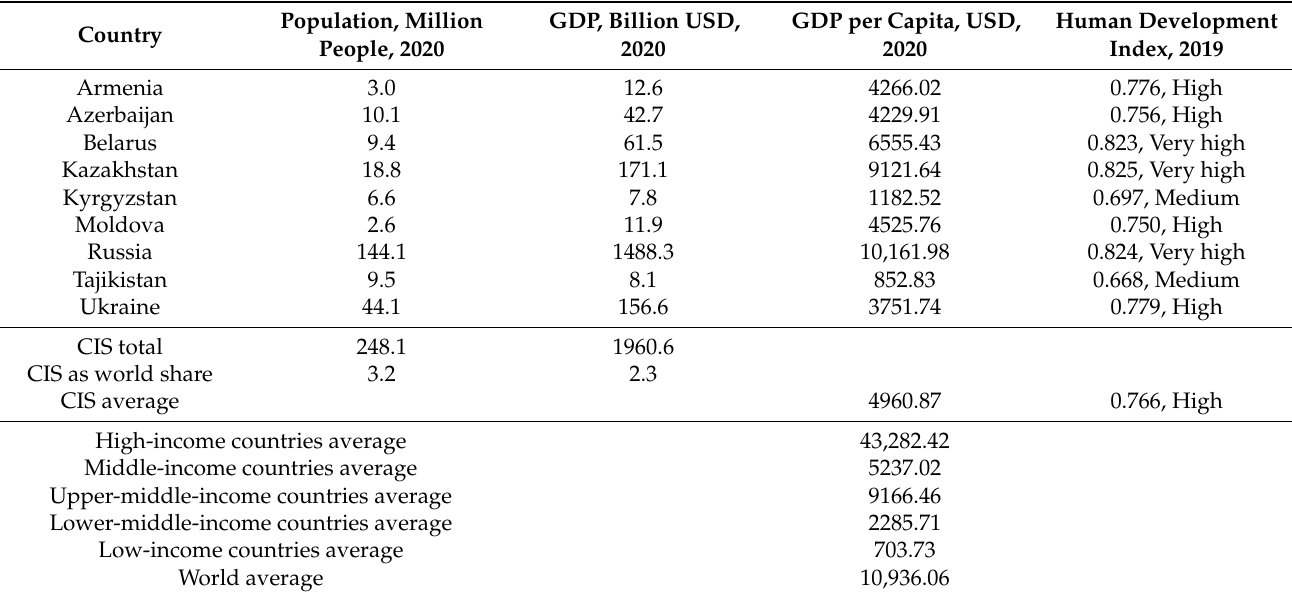
Table 1. Major Economic and Social